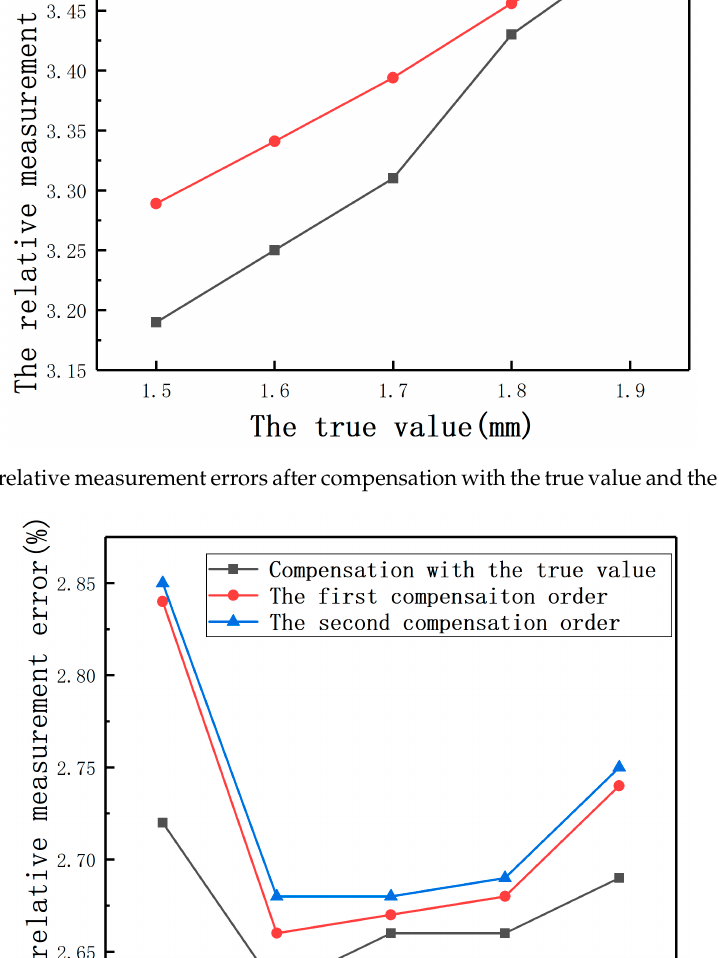
Figure 37. The relative measurement errors after compensation with the true value and the output value.